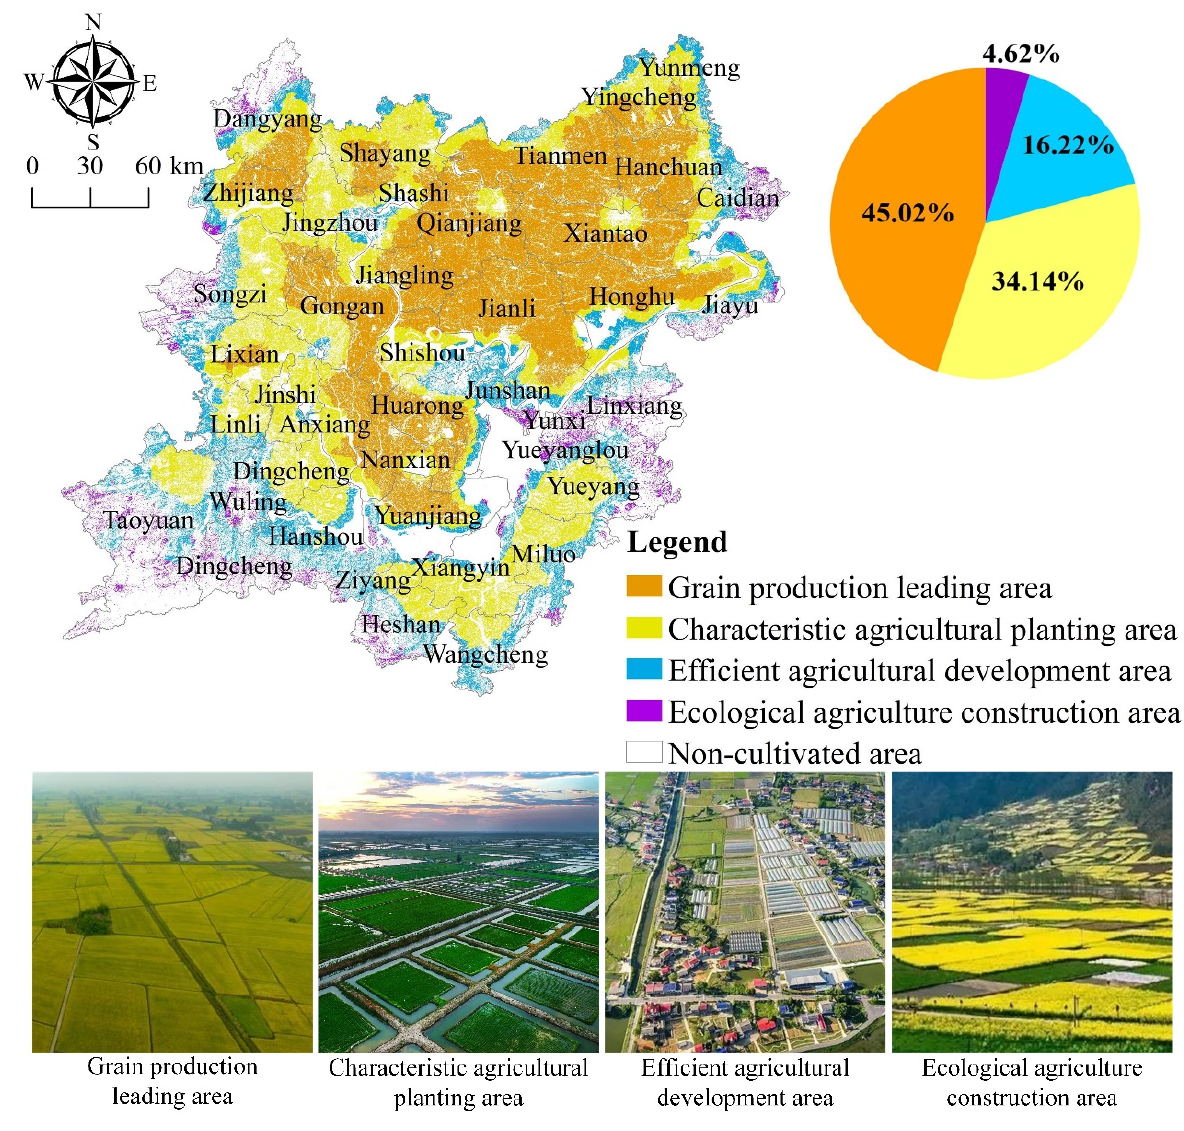
Figure 14. Multifunctional comprehensive zoning map of cultivated land system in the two lake plains.